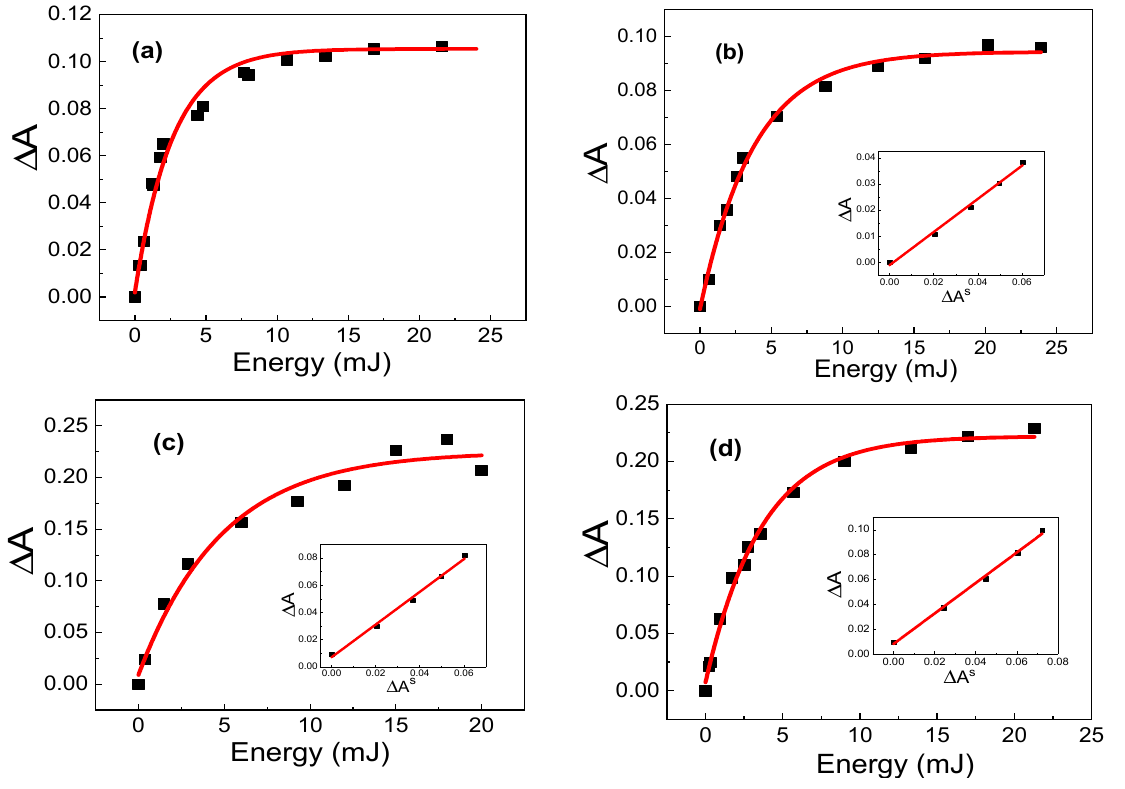
Figure 4. Transient absorption ∆ A in function of the exciting pulse energy for: ( a ) TMPyP, ( b ) TPPS 4 , ( c ) ZnTMPyP and ( d ) ZnTPPS 4 . Insets: ∆ A as a function of ∆ A s . Table 1. Parameters used to calculate the triplet quantum yield in accordance with equation (16a), quantum yield values, determined in this study (𝜑 (cid:2904)∗ ) , obtained from the kinetic analysis (𝜑 (cid:2904)∗∗ ) and average values, calculated from literature (𝜑 (cid:2904)∗∗∗ ).